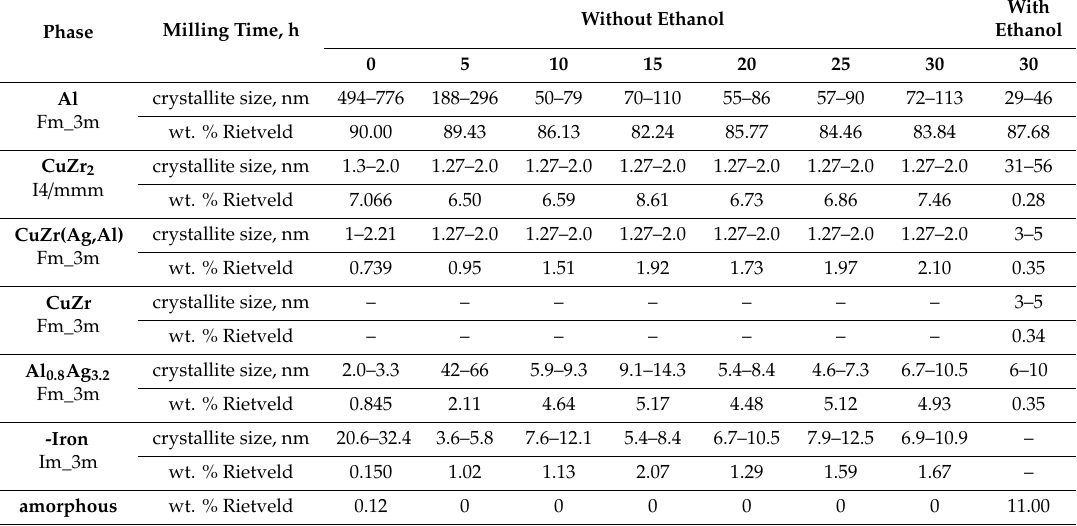
Figure 3. Backscattered SEM images ( a ) and particle size distribution ( b ) of mixed powders milled for different periods of time.